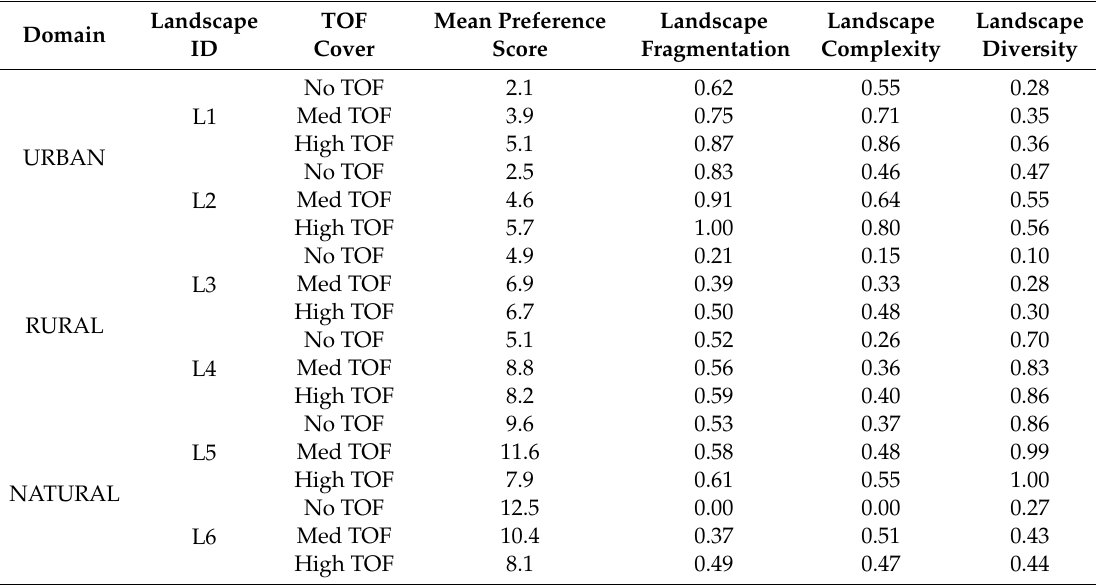
Table 3. Mean preference scores and normalized landscape metrics of the six landscape types investigated in relation to three di ff erent levels of TOF cover.